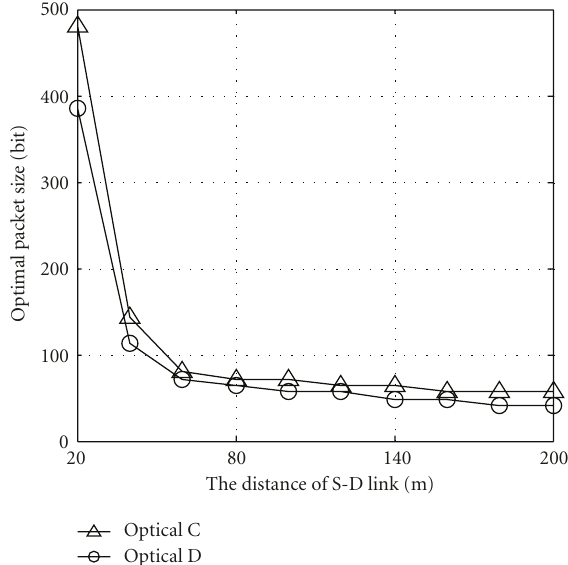
Figure 6: Optimal packet size versus the S-D distance for coopera- tion and direct transmission